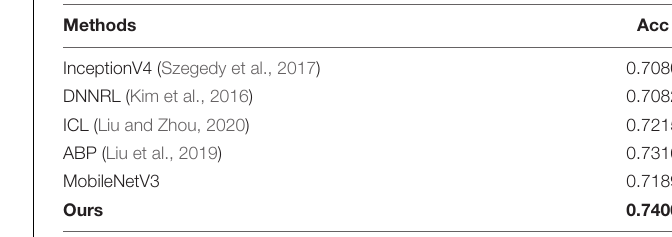
TABLE 1 | Comparison of experimental results with different